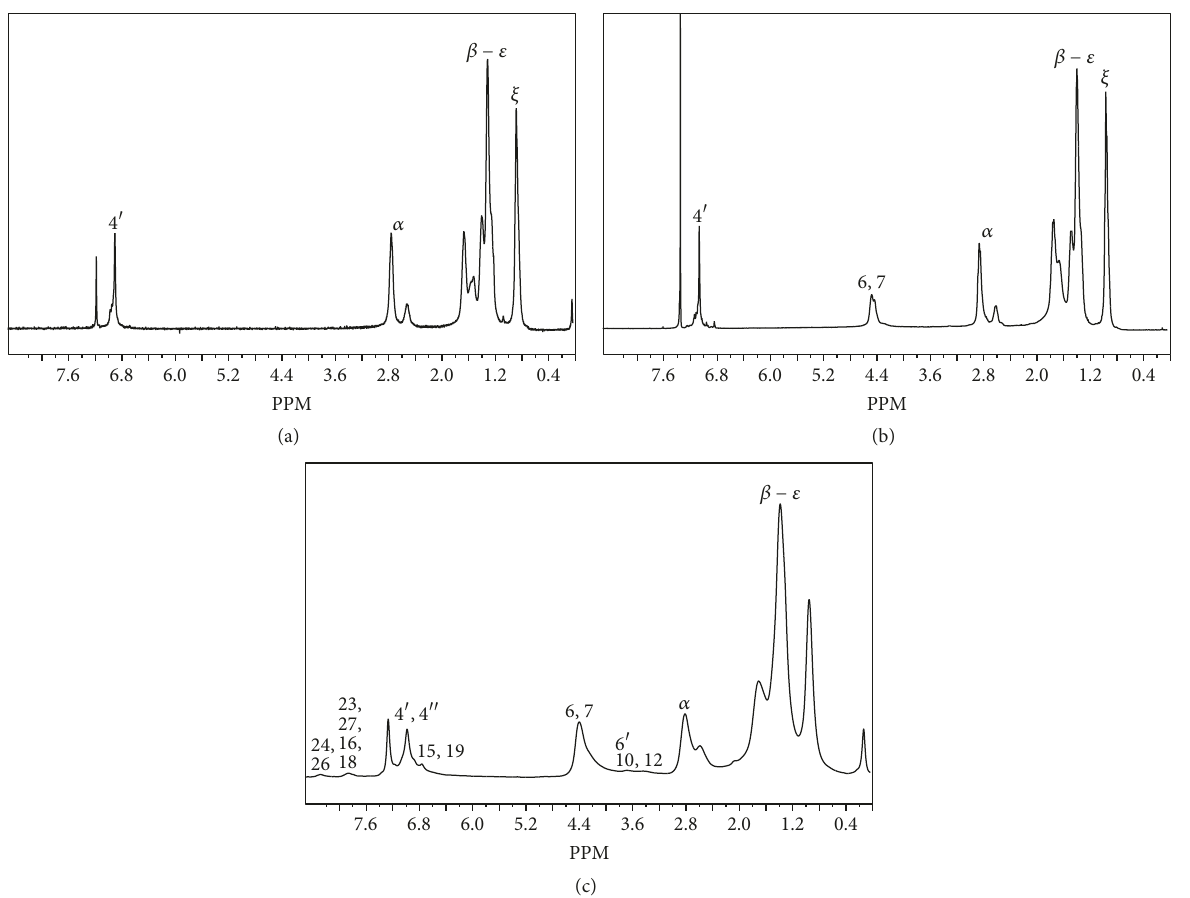
at 2.5 and 2.7 ppm, and H4 󸀠 bonded to the thiophene ring at approximately 6.9 ppm. Poly(3-HT- co -EDOT) (Figure 2(b)) presented the same signals as poly(3-HT)-2 and the sig- nals corresponding to the methylene protons of EDOT at 4.4